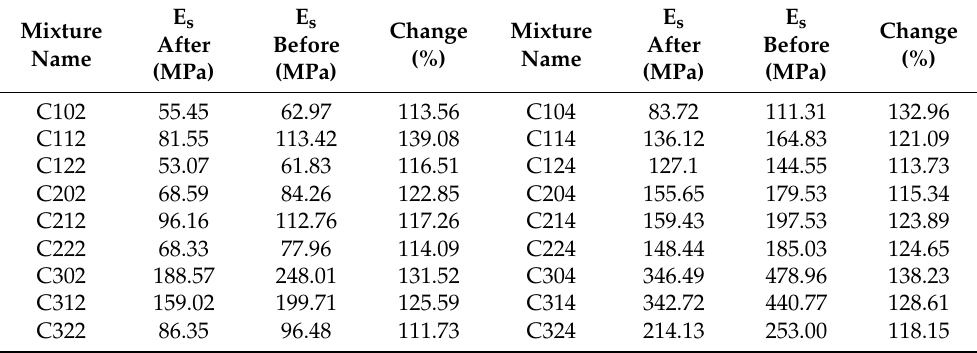
Figure 10. Values of tangent modulus E t ( a ) after 7 days of care and ( b ) after 28 days of care. Table 7. Effect of interpretation on modulus values E s .